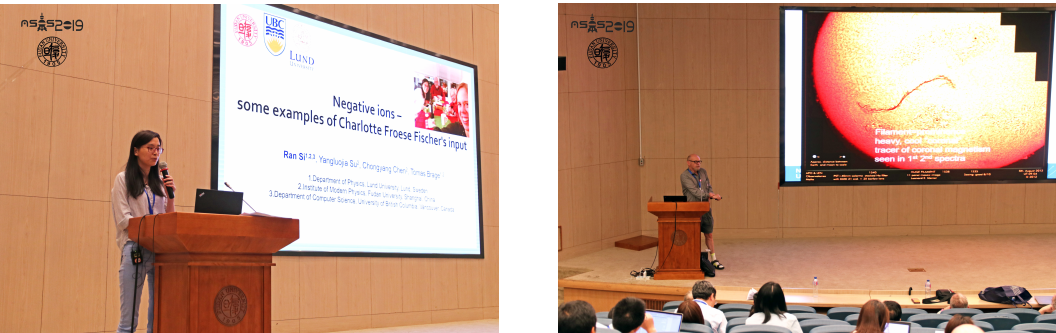
Figure 3. Prof. Alan Hibbert ( left ) giving a report and showing a video message from Prof. Charlotte Froese Fischer.